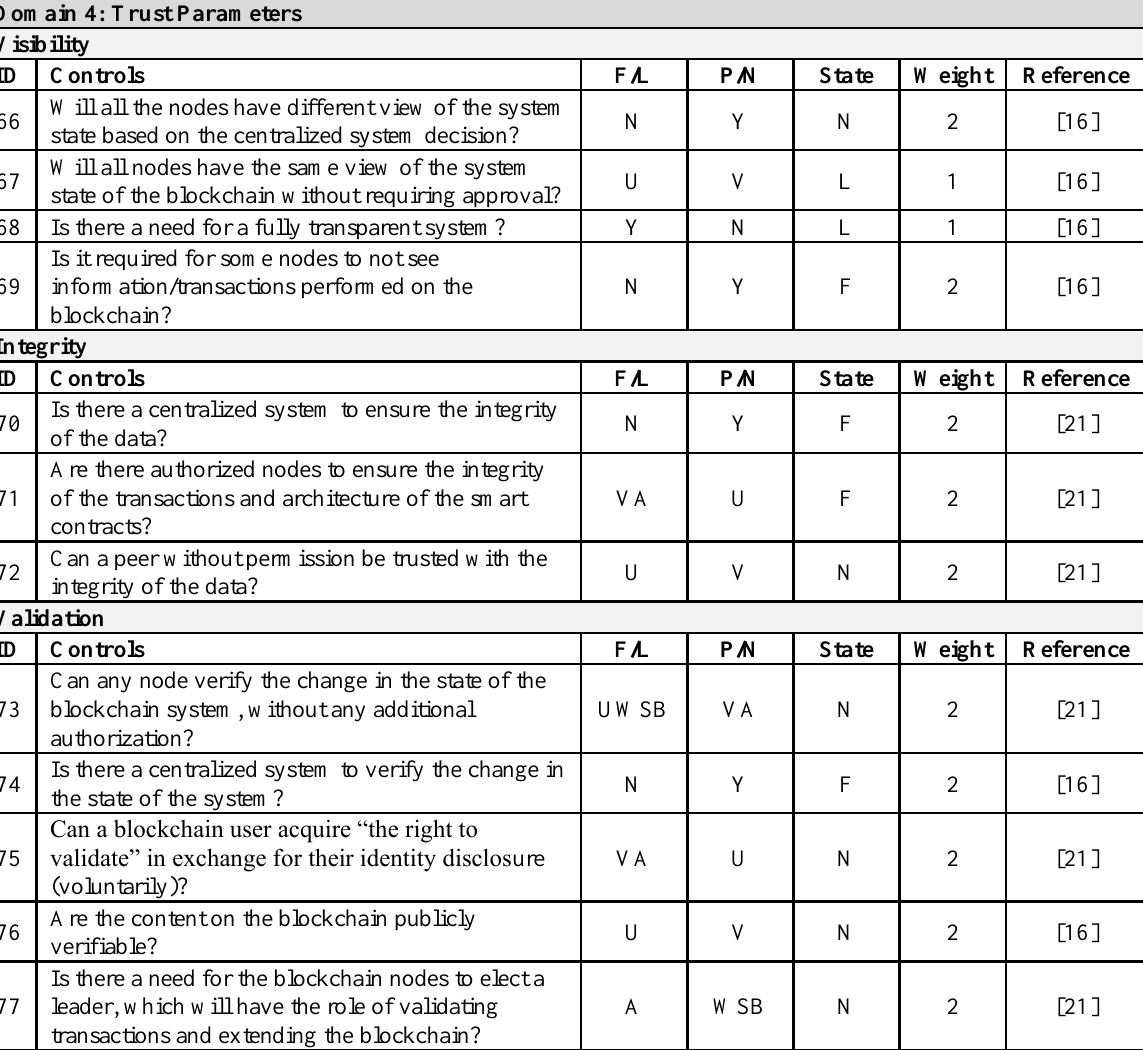
Table 5. Domain 4 of the blockchain applicability framework